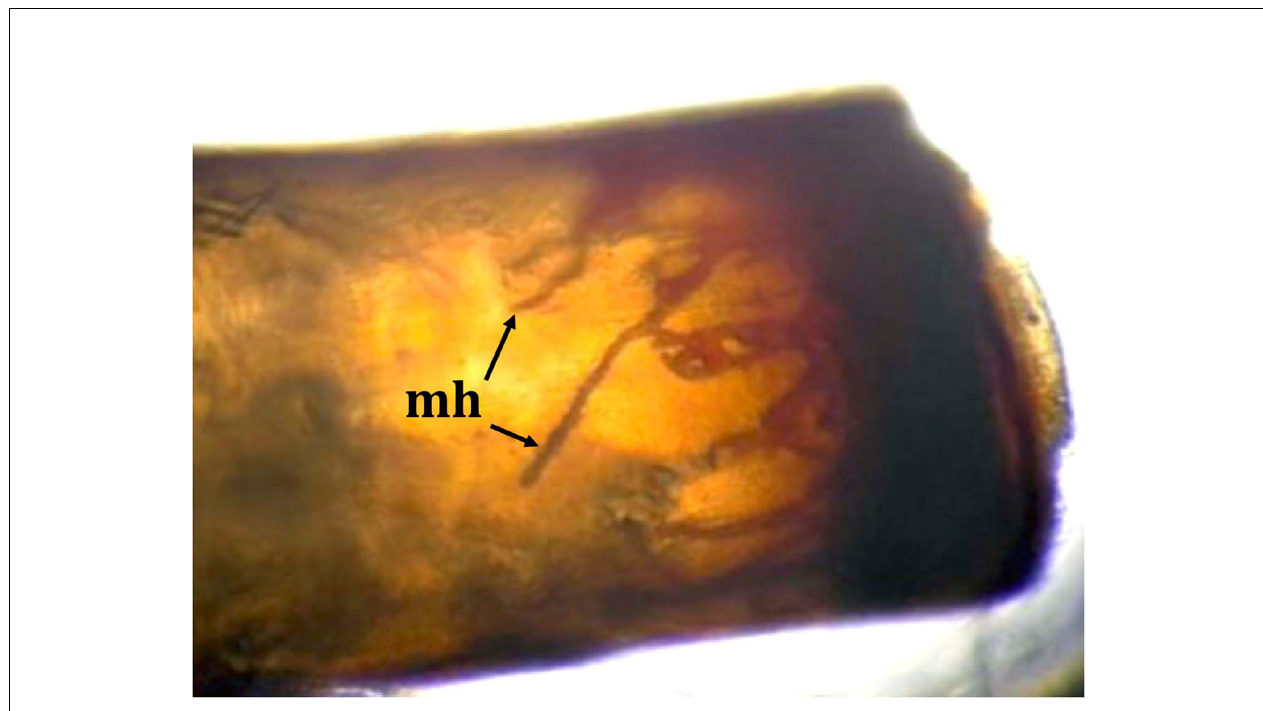
FIGURE 2 | A pereiopod of a Procambarus clarkii specimen from Reservoir Cachí, Costa Rica, showing the presence of melanized hyphae (mh), signs of a strong immune reaction against the crayfish plague pathogen Aphanomyces